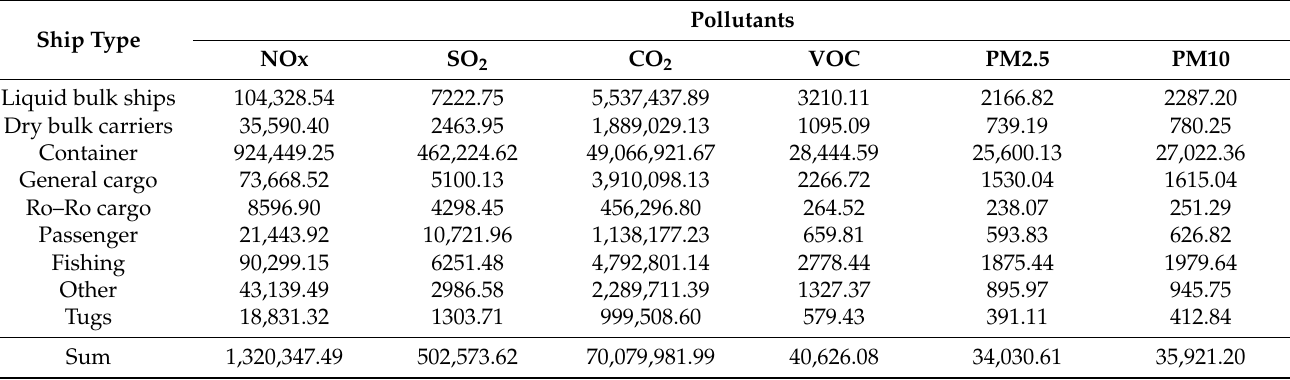
Table A4. Ship pollutant emissions by ship type at Busan Port in 2018 (ship activity phase: Hoteling)